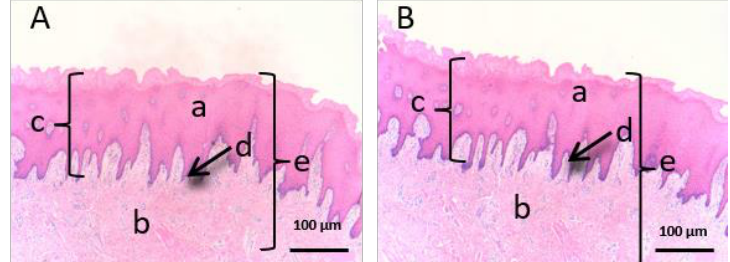
Figure 6. Histological images of vaginal mucous. ( A ): Untreated vaginal mucous observed at 400× and ( B ): Vaginal mucous treated with CP-Sat observed at 400×. a: stratified flat keratinized epithelium; b: own laminate and c: basal layer.